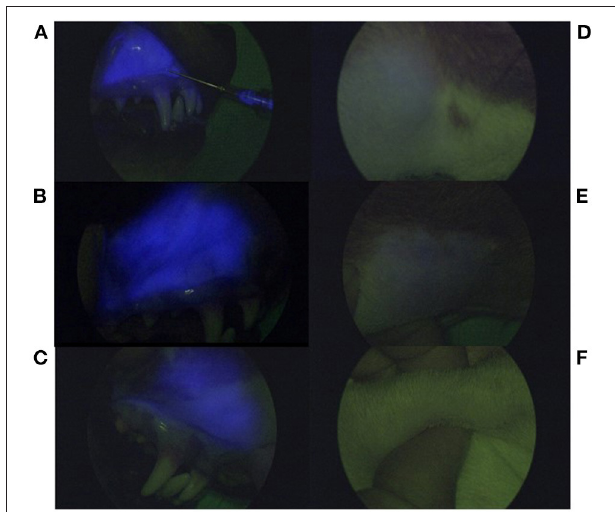
FIGURE 5 | Serial near infrared fluorescence images using a NIR exoscope. Fluorescence appears as blue based on the exoscope algorithm and is present at the injection site (A–C) during injection administration (A) , 4 days post-injection (B) , and 10 days p.i (C) . Images ( D–F ) demonstrate percutaneous fluorescence present at the right mandibular lymphocentrum at day 1 (D) and day 4 p.i (E) . There is no longer percutaneous fluorescence detected within the right mandibular lymphocentrum at day 10 p.i (F)